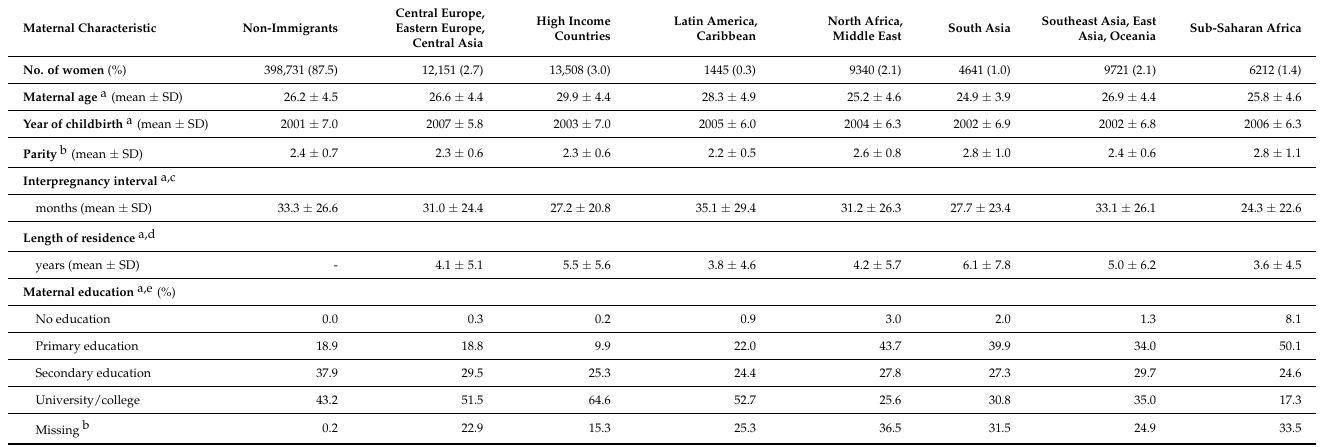
SD: standard deviation. a Reported for 1st pregnancy. b Mean for women with at least two pregnancies. c Missing interpregnancy interval ( n = 1058). d Missing length of residence ( n = 645). e Missing educational level ( n =